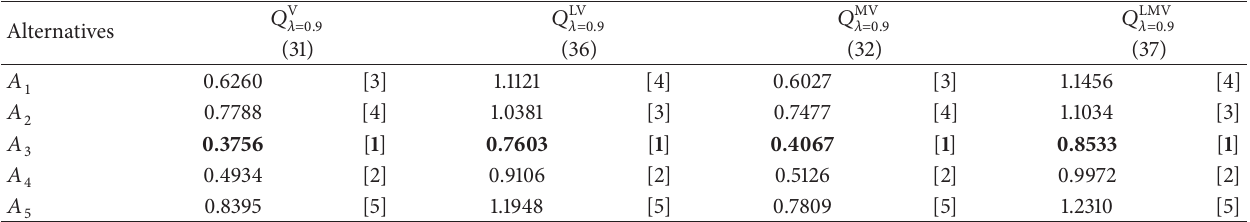
Table 14: Ranking of alternatives with respect to values of 𝑄 V , 𝑄 LV , 𝑄 MV , and 𝑄 LMV for 𝜆 = 0.9 .